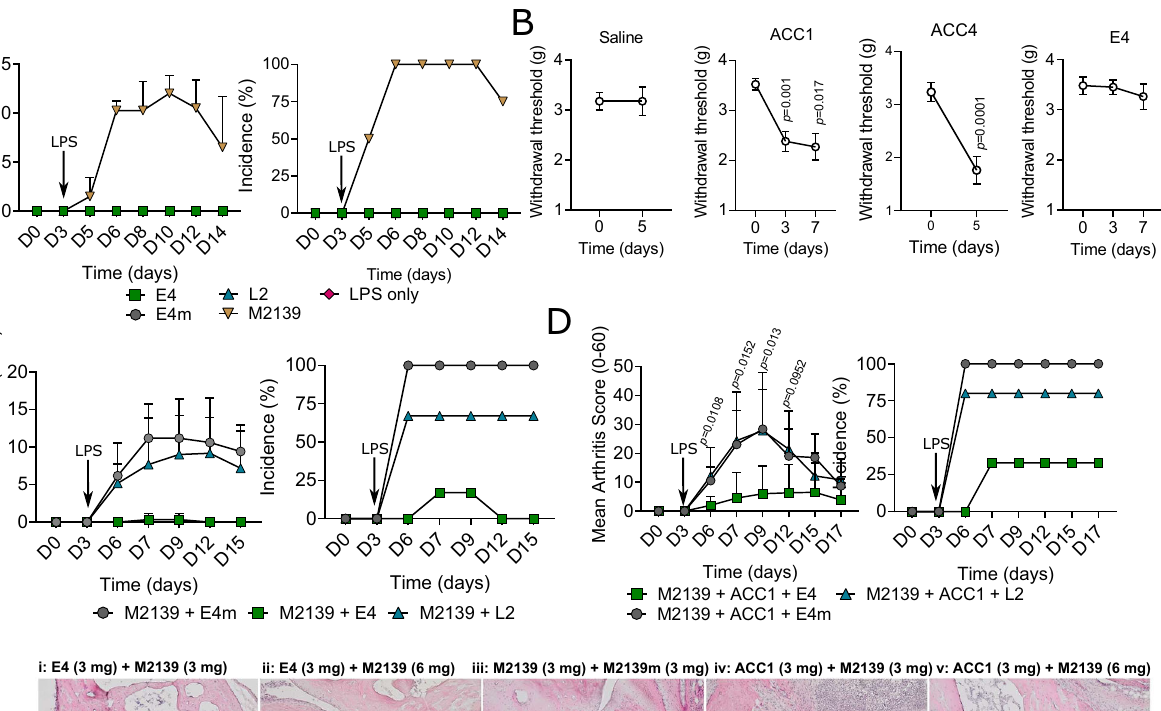
on day 0. Datawereanalyzed using Mann – Whitney test(two-tailed) and presented asmean±SD. E RepresentativeH&Eandtartrate-resistantacidphosphatase(TRAP) staining on joint tissue sections from the CAIA experiment. Scale bars represent 100 µ m. F Histological assessment for each group ( n =5 for group iii and 6 for others). Data are analyzed using one-way ANOVA and presented as mean±SEM. G Quanti fi cationofosteoclastnumbersincartilagesectionsfromtheTRAPstaining ( n =5 for group i and 6 for others). Data are assessed using one-way ANOVA and presented as mean±SEM. H E4 protects mice against glucose-6-phosphate iso- merase (G6PI) induced arthritis (GPIA). DBA/1 mice were subcutaneously immu- nized with hGPI 325-339 peptide (10 μ g/mouse) on day 0 together with E4 (2mg, n =9) or PBS ( n =15). Data are analyzed using Mann – Whitney test (two-tailed) and presented as